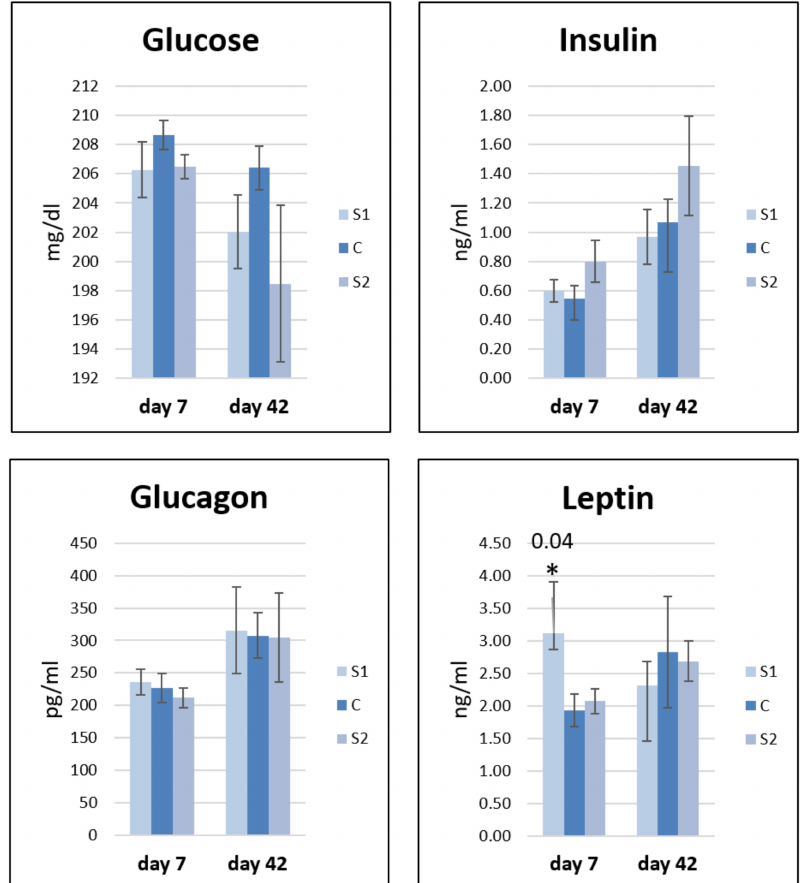
Figure 4. Changes in biochemical (glucose) and hormonal (insulin, glucagon, and leptin) profiles in response to an early stimulation in ovo with synbiotics (S1) Lactobacillus salivarius with GOS or (S2) Lactobacillus plantarum with RFO and saline as the control (C). Statistical analysis consisted of comparing the experimental groups with the control group by Student’s t -test (* for p < 0.05; exact p value). Standard errors of the mean (SEM) are marked with the lines; n =